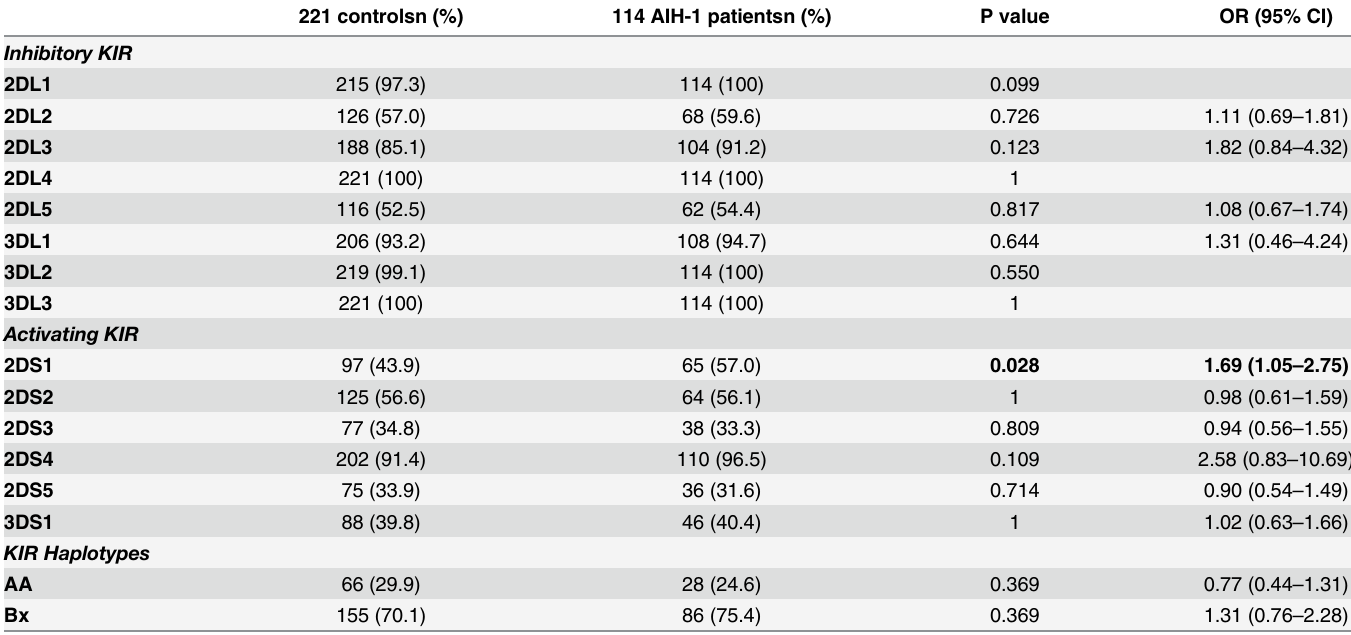
Table 3. Comparisons of KIR gene frequencies and KIR haplotypes between patients with type 1 autoimmune hepatitis and controls. 221 controlsn (%)